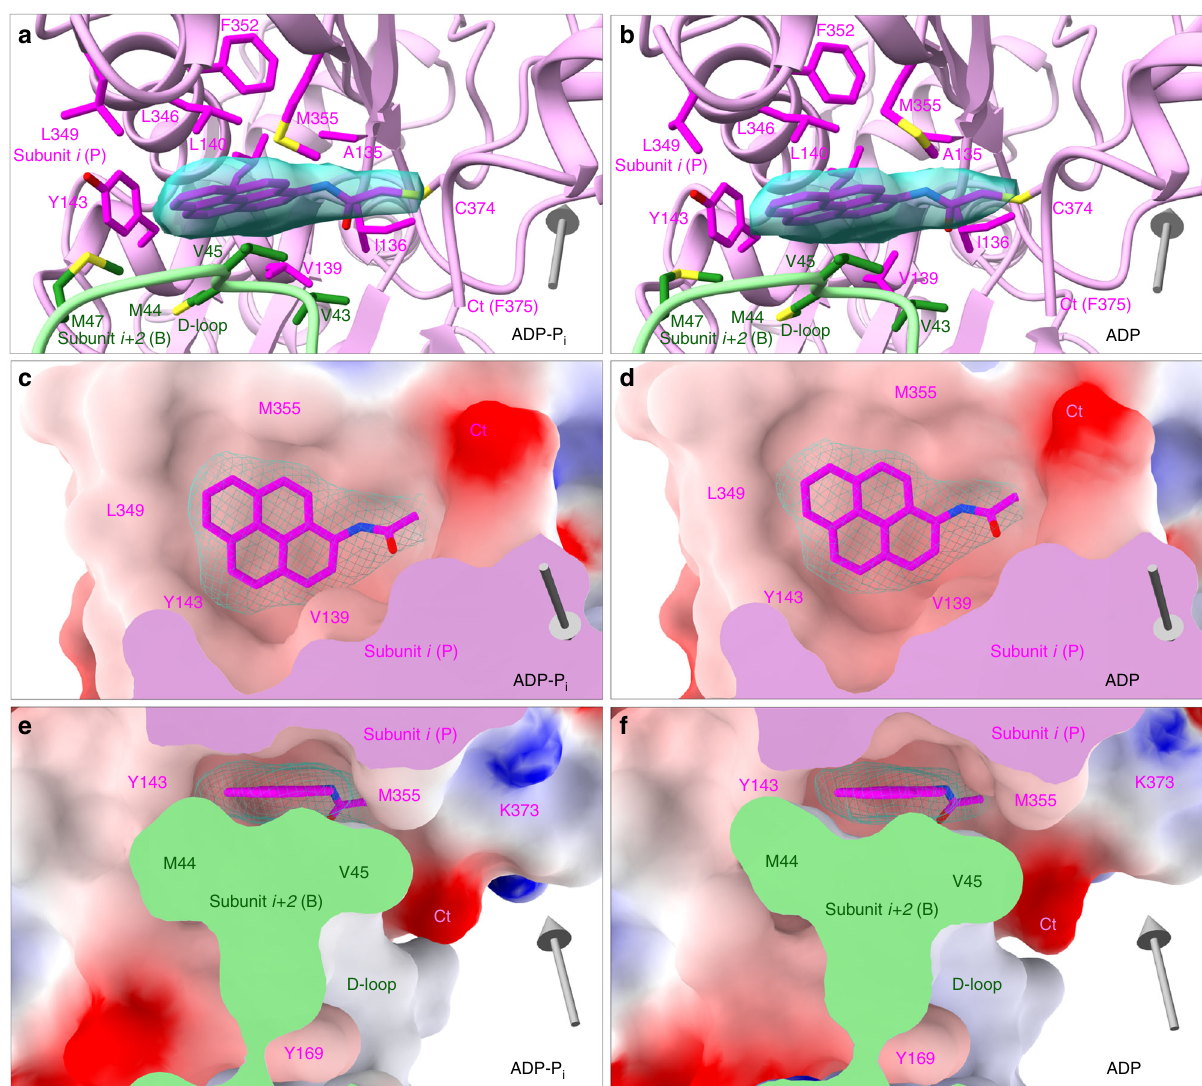
Fig. 2 N-(1-pyrene) conjugated to C374 in a hydrophobic pocket between two subunits along the long-pitch helix of the actin fi lament. EM map densities of N-(1-pyrene) are shown as turquoise mesh surfaces and N-(1-pyrene) as magenta stick fi gures. Gray arrows show the fi lament orientation with arrowheads pointing to the pointed end. a , c , e Filaments with bound Mg-ADP-P i ; b , d , f fi laments with bound Mg-ADP. a , b Backbone ribbon diagrams. The actin subunit toward the pointed end is colored plum and the subunit toward the barbed end is light green. c , d , e , f Electrostatic potential surfaces (blue: positive; red: negative) of interacting actin subunits. c , d Face views; e , f side views. Neighboring subunits in ( c ) and ( d ) are omitted for clarity. The cut surfaces of the two actin subunits in the section views are colored in plum and light